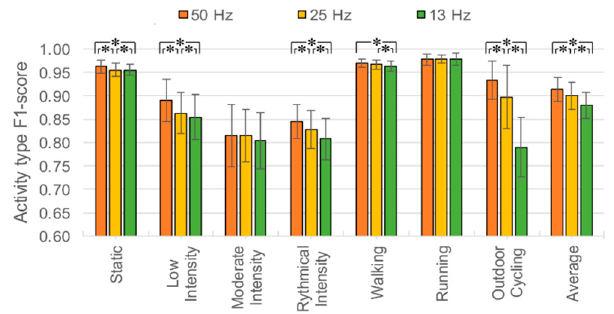
Figure 5. F1-score of different activity types (mean ± SD) averaged over window lengths and feature sets using different sampling frequencies. Asterisks show a significant statistical difference between different values of the sampling frequency ( p < 0.05).